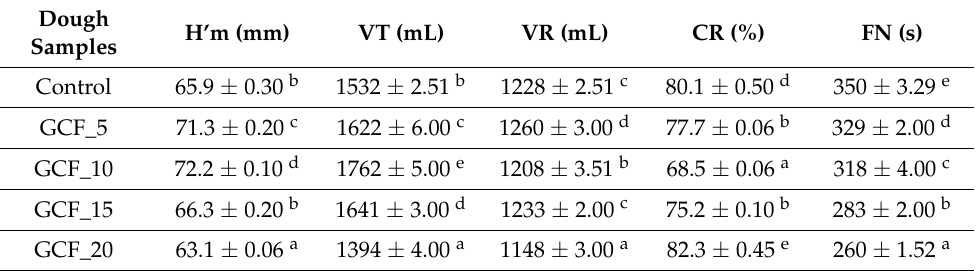
Table 3. Rheofermentometer and falling number data of dough samples with different levels of GCF addition to wheat